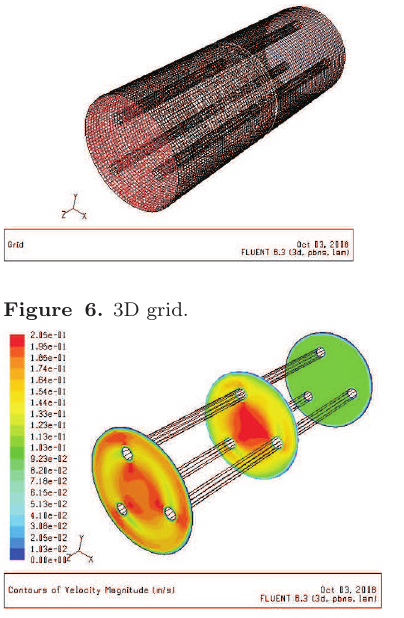
Figure 8. Magnitude of velocity. Figure 9. Vectors of velocity in